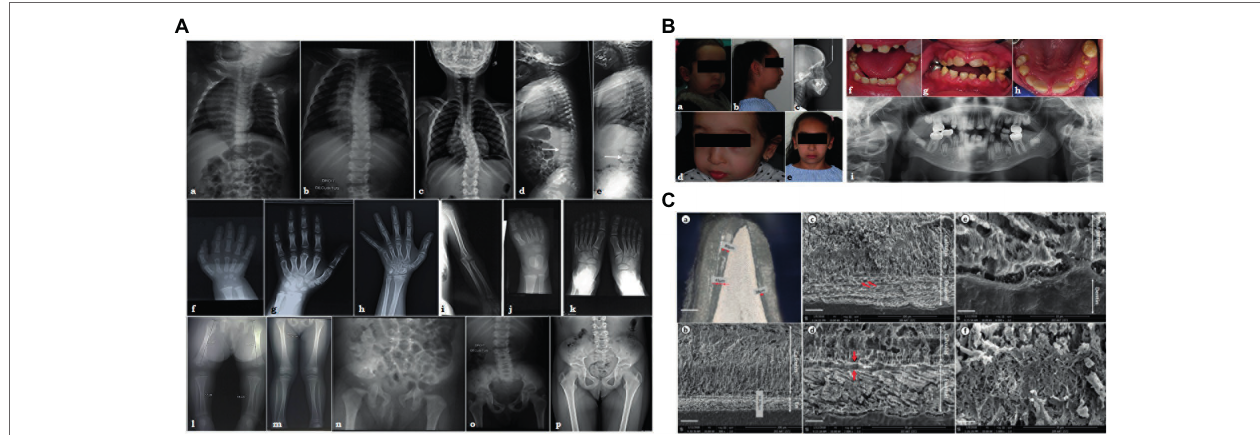
FIGURE 1 | (A) X-ray images of the skeletal anomalies at 3 months old (a,d,f,j,l,n) , 4 years old (b,e,g,i,k,m,o) and 9 years old (c,h,p) . Radiographs of the vertebral column showed the progressive scoliosis (a–c) and the ballooning of the vertebrae (d,e) . Radiographs of hands and feet (f–h,j,k) displayed a progressive carpal and tarsal ossification. The patient also presented with short long bones (i,l,m) , a genu valgus (l) , and a horizontal acetabulum (n–p) . (B) Clinical and radiological images of the facial and dental anomalies at 2 years old (a,d,f) and 9 years old (b,c,e,g–i) . AI is visible in the clinical intraoral photographs affecting both the primary (f) and permanent dentition (g,h) . The panoramic radiograph showed no radio-opacity contrast between dentine and enamel (i) . (C) Optical numeric microscope and scanning electronic microscopy (SEM) of primary teeth. Numeric optical view of a sagittal section of a primary tooth. Dentine appears brighter than enamel. Lower central primary incisor (a) . SEM micrograph of the thin enamel layer covering the vestibular side of the tooth. A thick layer of calcified calculus is present (b) . Higher magnification of the thin enamel layer. Pseudo-prismatic structures are evident (arrows) (c) . Micrograph of the thin enamel showing an outer aprismatic layer (between red arrows) exhibiting incremental lines (white arrow) (d) . Enamel-dentinal junction showing typical scallops and unusual non-mineralized collagen fibers at the interface (e) . Higher magnification of the calculus material capping the tooth. Many entangled calcified filamentous bacteria are observed (f)